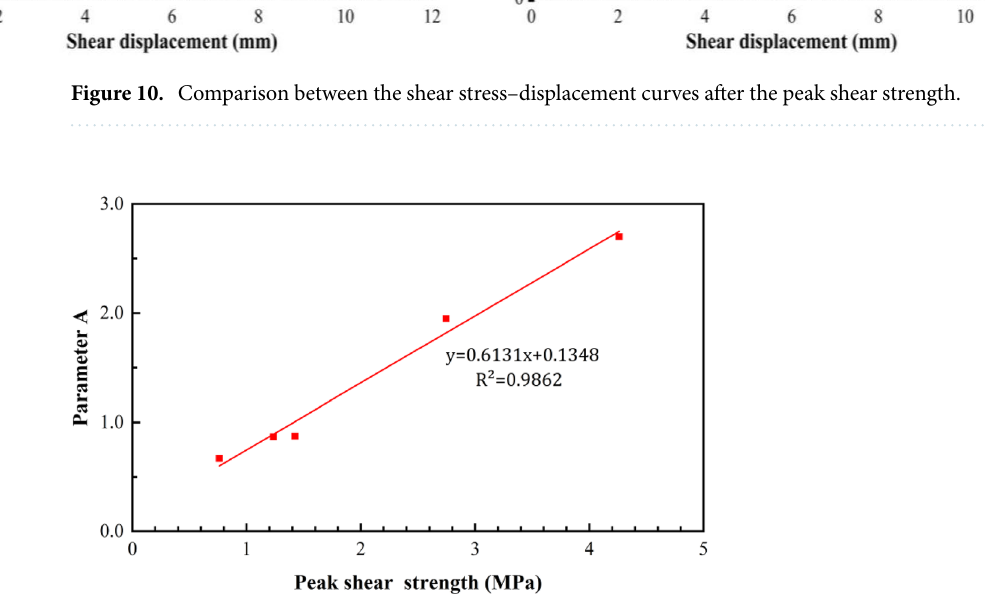
Figure 11. Trend of parameter A as a function of the peak shear